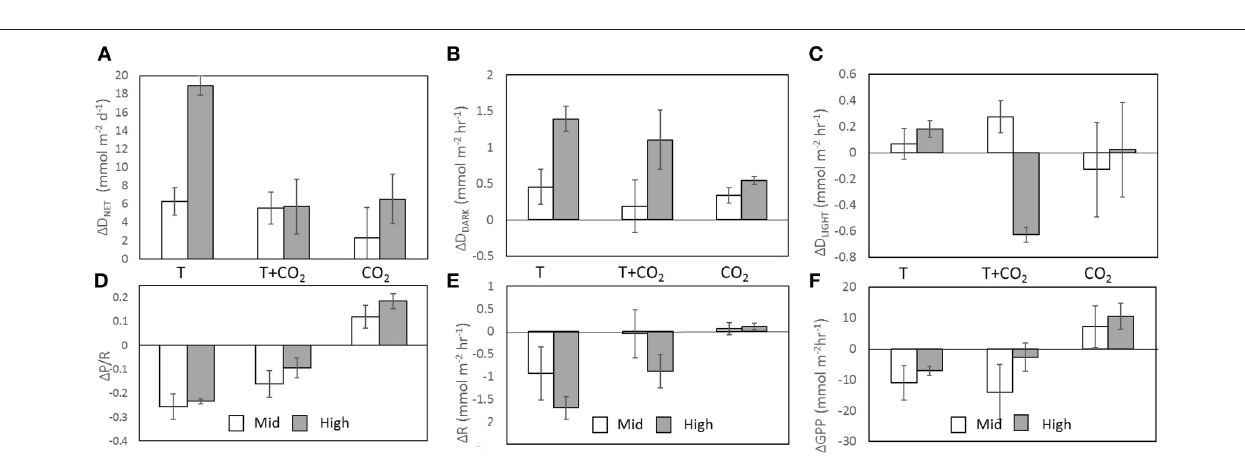
FIGURE 4 | 1 fluxes were calculated by subtracting the average flux of the controls ( n = 3) from the flux within each treatment chamber. Columns represent 1